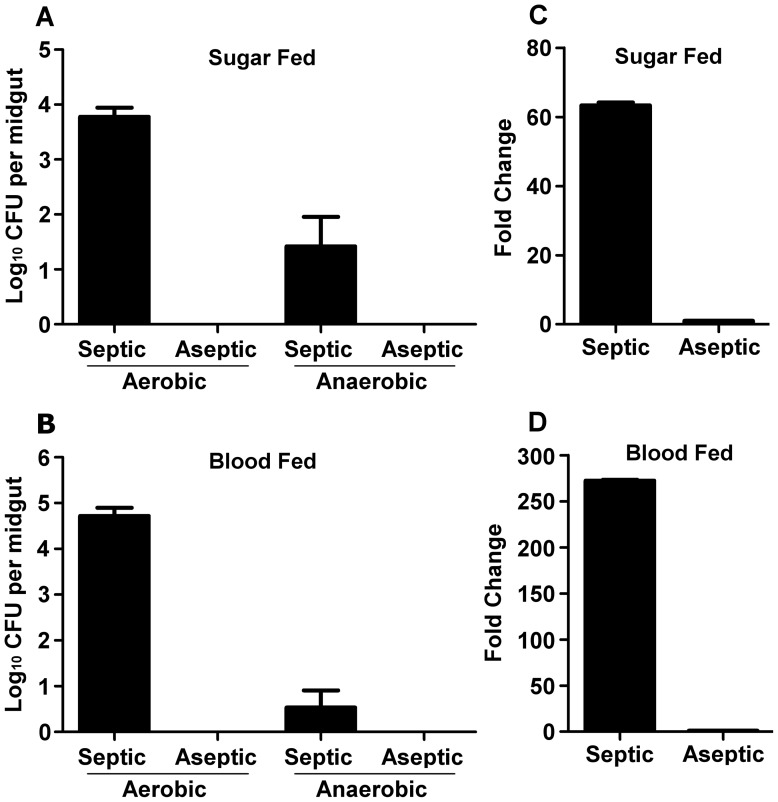
Removal of bacteria from the midgut by antibiotic treatment of adult female mosquitoes.Culture-dependent methods of bacterial cultivation (aerobic vs. anaerobic conditions) were unsuccessful at growing any bacteria from the midguts of aseptic (antibiotic-treated) mosquitoes after feeding on either (A) sugar or (B) 24 h post-blood meal. In contrast, bacteria from the midguts of septic (untreated) mosquitoes fed on (A) sugar or (B) 24 h post-blood meal could be cultured under aerobic and anaerobic conditions. (C) and (D) Culture-independent analysis of bacterial 16s rRNA by qRT-PCR measured almost no 16s rRNA in aseptic mosquitoes (sugar or blood-fed). For (A) and (B), colony forming units (CFU) from three biological replicates were pooled. For (C) and (D), 10 midguts from each treatment were assessed individually by qRT-PCR, and the relative amount of 16s rRNA from aseptic midguts (sugar or blood-fed) was compared to that of the septic (sugar or blood-fed) midgut groups, respectively. Black bars represent the mean CFU or mean -fold change, and error bars represent the standard error of the mean.